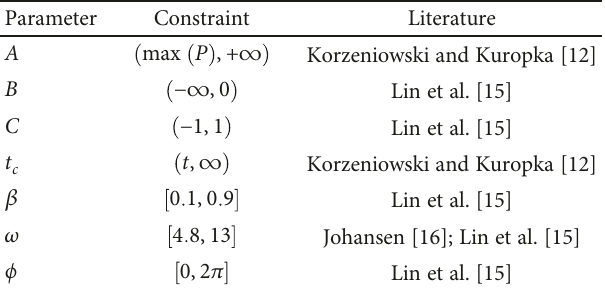
Table 1: Restriction on LPPL